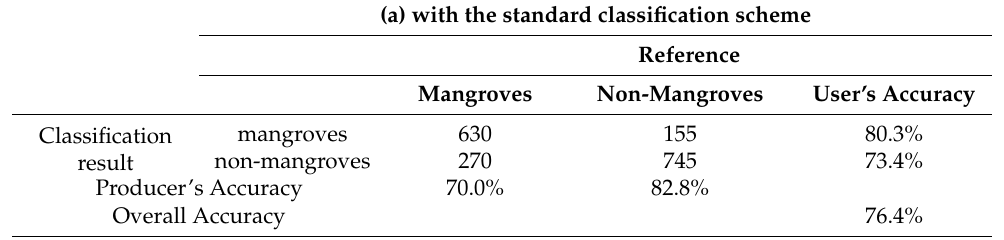
Table 5. Confusion matrices of the classifications without correction with a standard classification scheme and a new classification scheme in the second experiment. The performance of classification with the standard scheme is shown in ( a ), and that with the new scheme is shown in ( b ). (a) with the standard classification